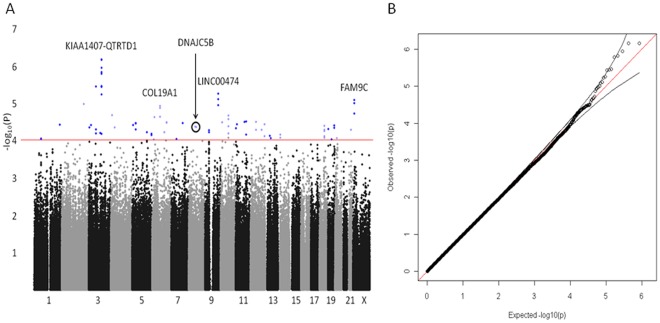
P-values from a combined case-only analysis of CARE and WOSCOPS.Panel A: A Manhattan plot of the P values from the combined case-only analysis of CARE and WOSCOPS. The x-axis corresponds to the chromosomal position for 22 chromosomes and the X chromosome. The Y axis corresponds to the negative base 10 logarithm of the P value. The red line indicates P = 10−4 and SNPs above this line are indicated in blue. Gene symbols are indicated above loci with P<10-5 in the combined analysis of CARE and WOSCOPS. The location of DNAJC5B is also indicated. Panel B: A quantile-quantile plot of the observed vs. expected P values. The black lines indicate the 95% CI associated with the expectation that, under the hypothesis of no association, the values will fall on the red diagonal.